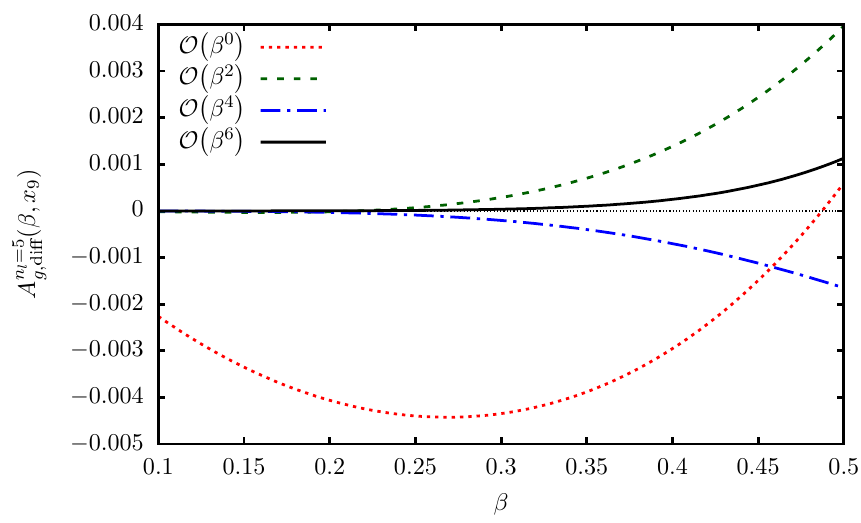
Figure 4 . The di(cid:11)erence between the threshold expansion for coe(cid:14)cient A g up to (cid:12) n with n = 0 ; 2 ; 4 ; 6 and results from numerical integration for a (cid:12)xed angle (cid:18) .